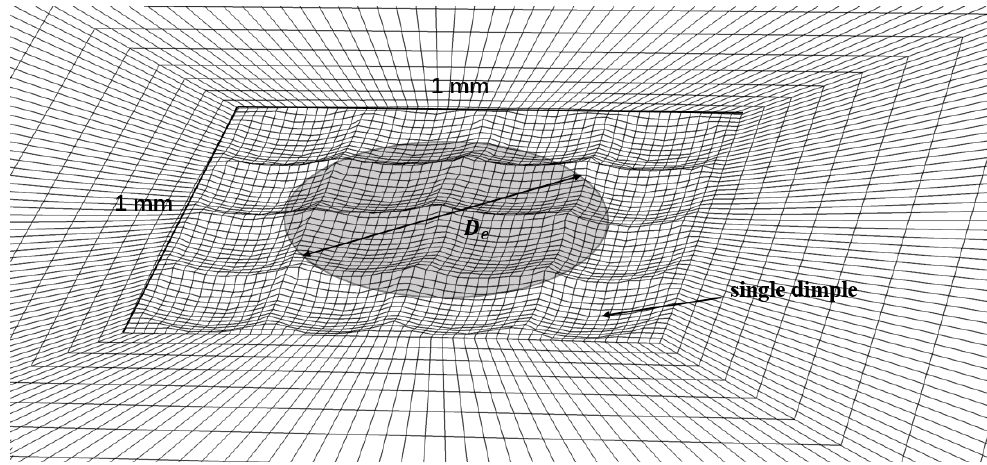
Figure 2. Schematic diagram of 100% coverage ratio dimple patterns: ( a ) N = 4 ordered dimple pattern; ( b ) N = 16 ordered dimple pattern; ( c ) N = 38 stochastic dimple pattern. Figure 3. The schematic diagram of residual stress evaluation area.